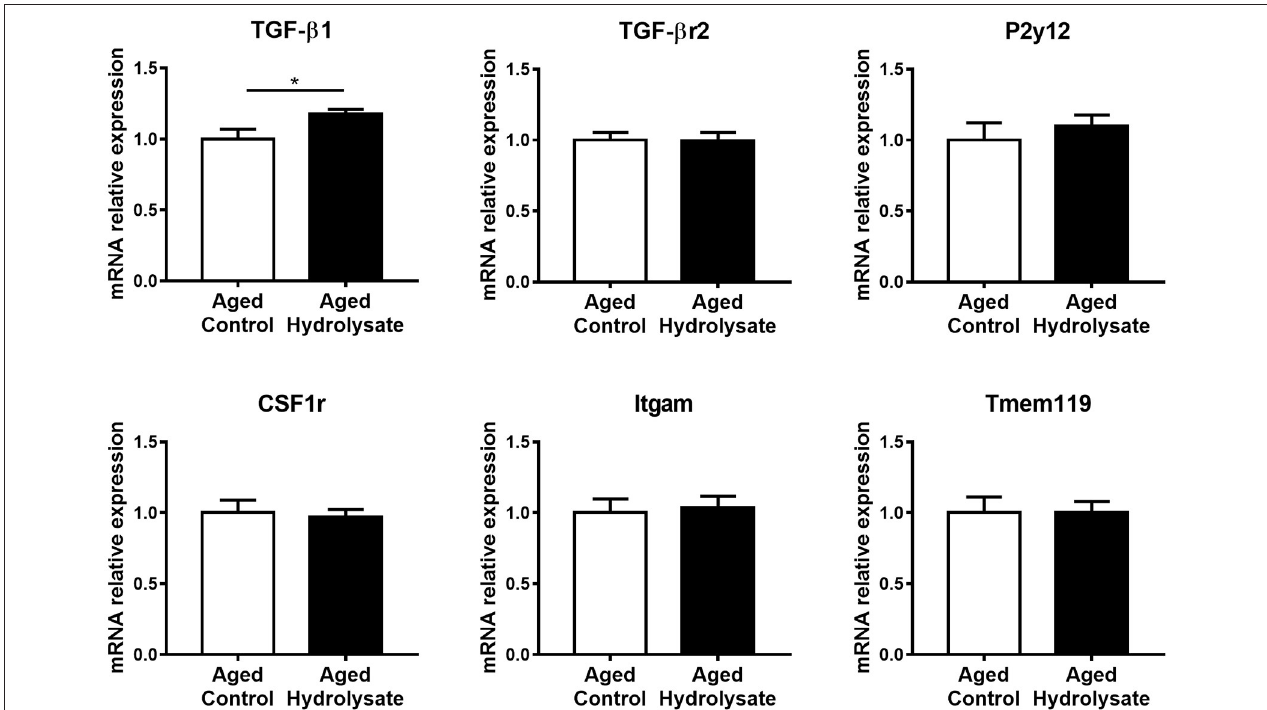
FIGURE 5 | Effects of the fish hydrolysate supplementation on homeostatic microglial signature in the hippocampus. mRNA expression of homeostatic microglial markers TGF β 1, TGF β r2, P2y12, CSF1r, Itgam, and Tmem119 in the hippocampus of aged mice fed with the control diet or the hydrolysate-enriched diet for 10 weeks (* p < 0.05 by unpaired t -test; n = 8 per group). Data are presented as mean ±